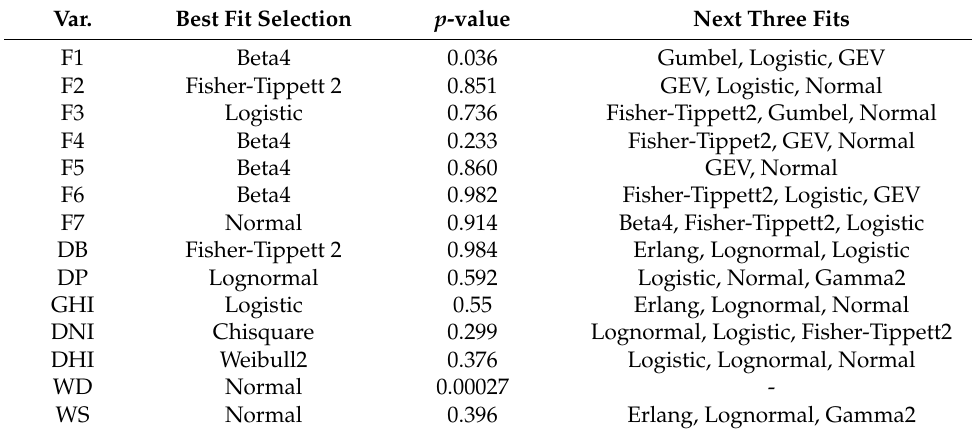
Table A7. Summary of the BestFit distribution used in this